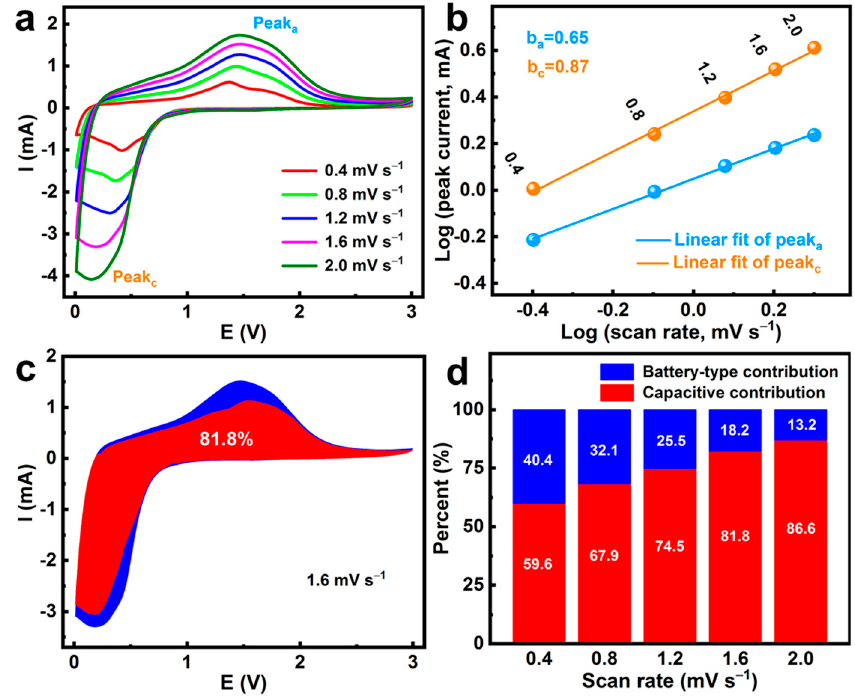
Figure 6. ( a ) CV curves with different scan rates, ( b ) log i vs. log v profiles, ( c ) the capacitive contribution (red region) and battery-type contribution (blue region) at 1.6 mV s -1 , and ( d ) normalized capacitive (red region) contribution ratios at different scan rates.